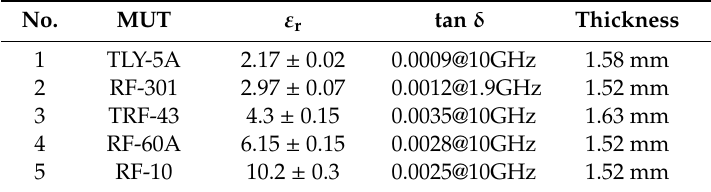
Table 2. Relative permittivity, loss tangent, and thickness of the five MUTs.